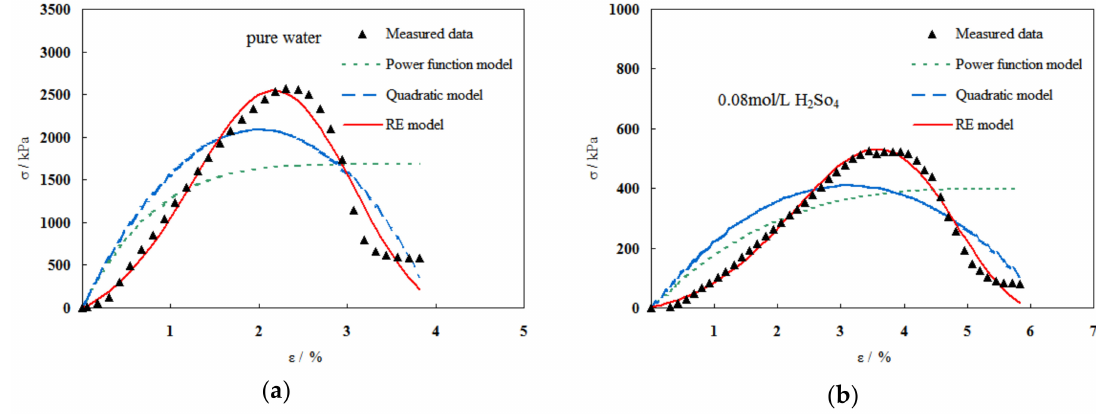
Figure 9. Comparison of stress–strain curves: ( a ) pure water condition (0 mol / L H 2 SO 4 ); ( b ) 0.08 mol / L H 2 SO 4